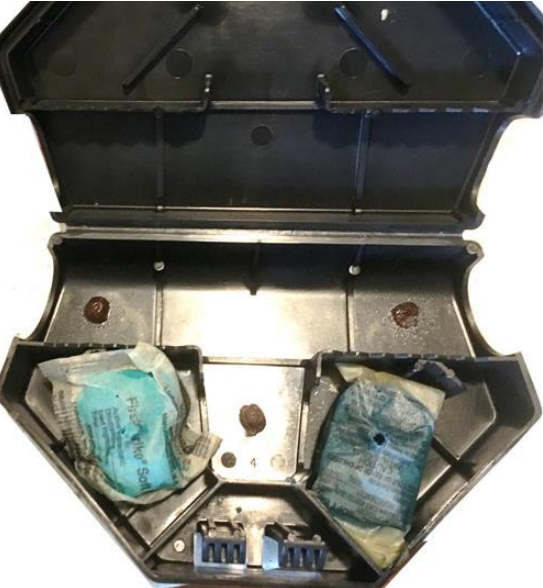
Figure 2. A Protecta ® EVO ® Mouse bait station with two toxic baits (Left: FirstStrike ® soft bait; Right: Contrac ® soft bait) and three dollops of chocolate spread.